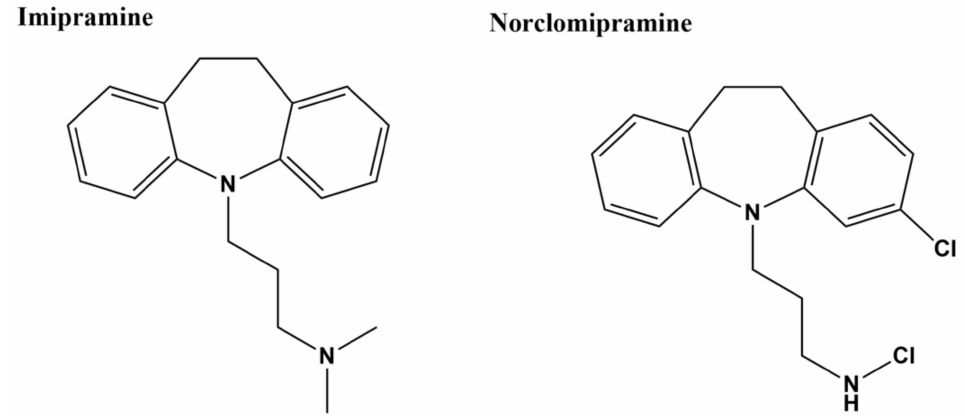
Figure 3. Structures of tricyclic antidepressant imipramine and metabolite